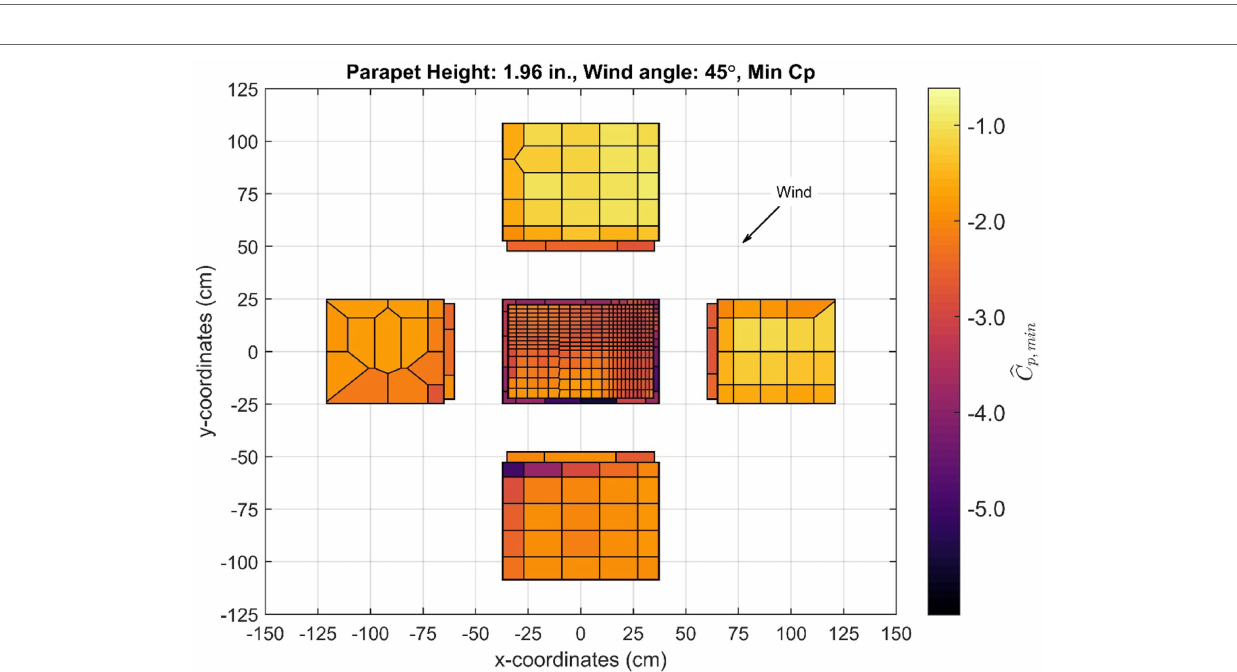
FIGURE 14 | Minimum pressure coefficients for optimal parapet height, 45° wind angle shown.